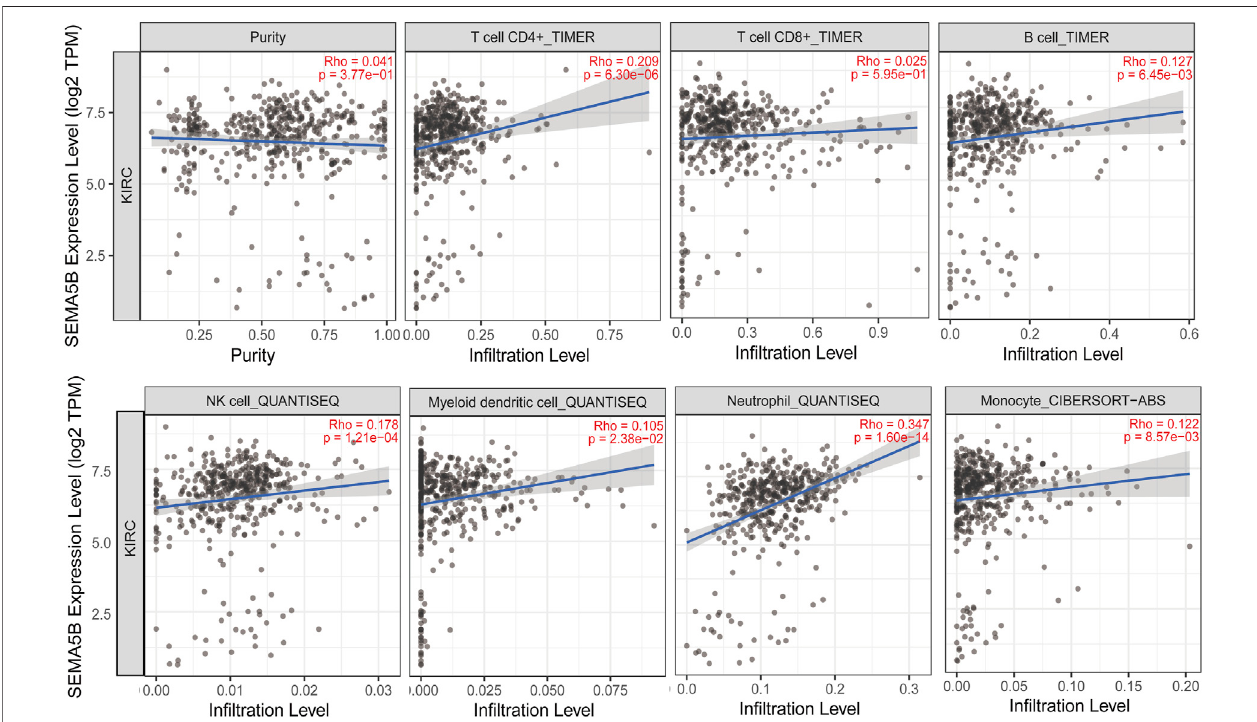
FIGURE 6 | Correlation of SEMA5B expression with immune in fi ltration level in KIRC. The study was performed. The correlation between the SEMA5B expression and immune cells was conducted in the TIMER database and evaluated by Spearman ’ s correlation.